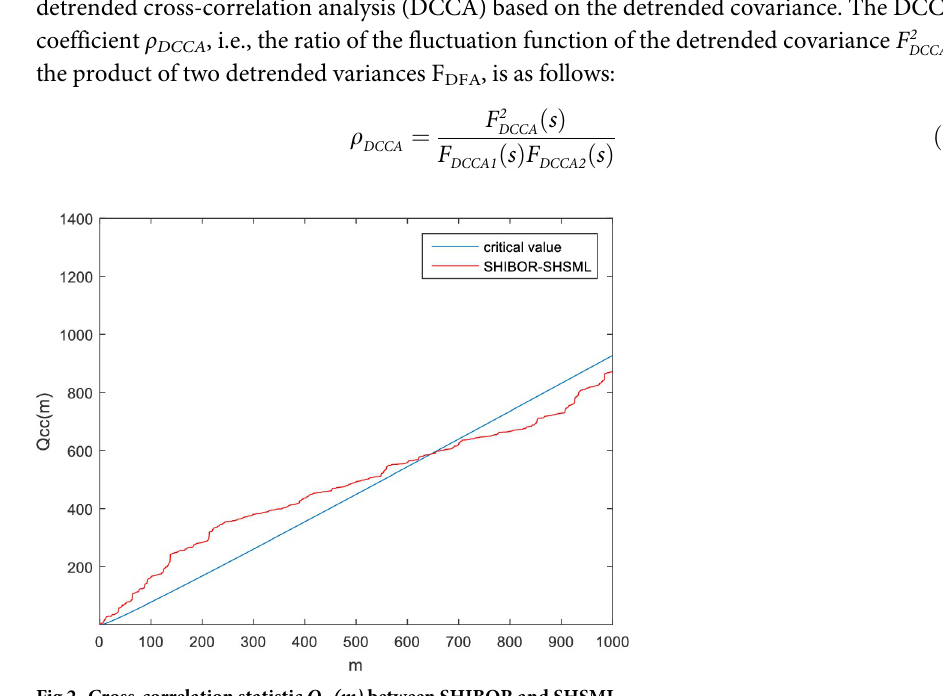
Fig 2. Cross-correlation statistic Q cc (m) between SHIBOR and